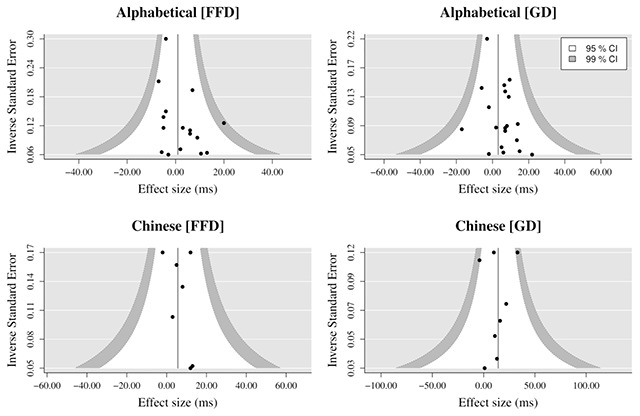
Funnel plots of the studies included in the meta-analysis. In the absence of bias, more precise studies are expected to appear narrowly at the top of the plot, whereas less precise studies are expected to scatter more widely at the bottom of the plot.